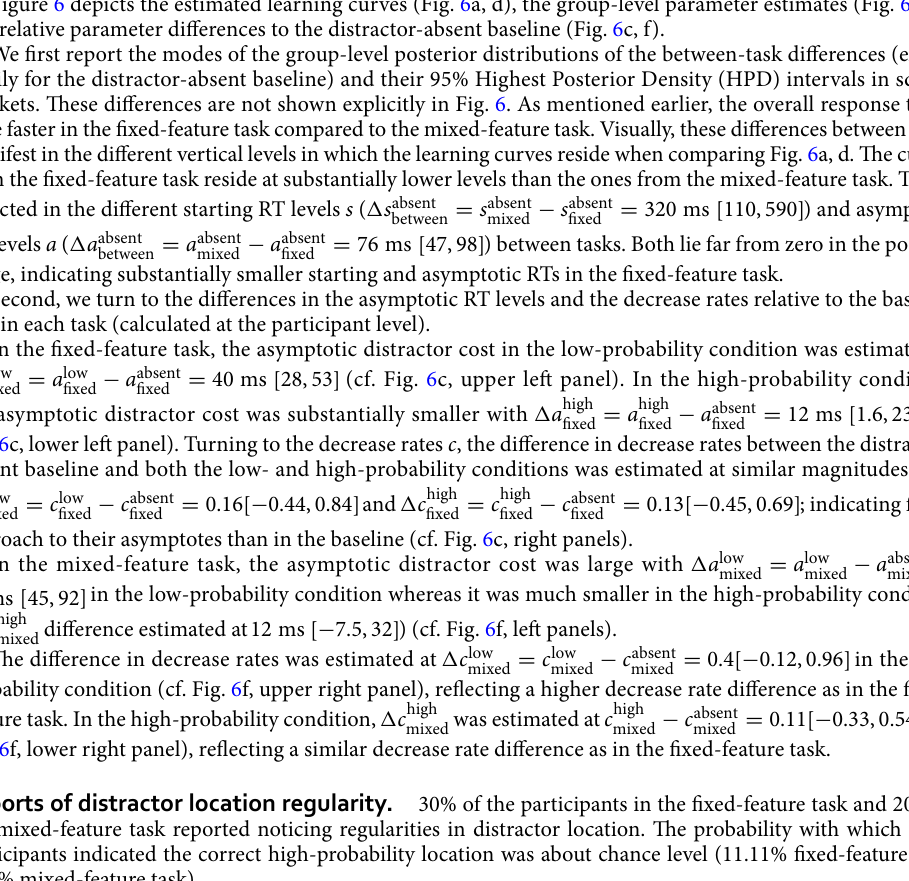
Figure 5. Illustration of the learning curve model. The annotations in the figure highlight the measurement range (Block 1 to 8) and visualize the model